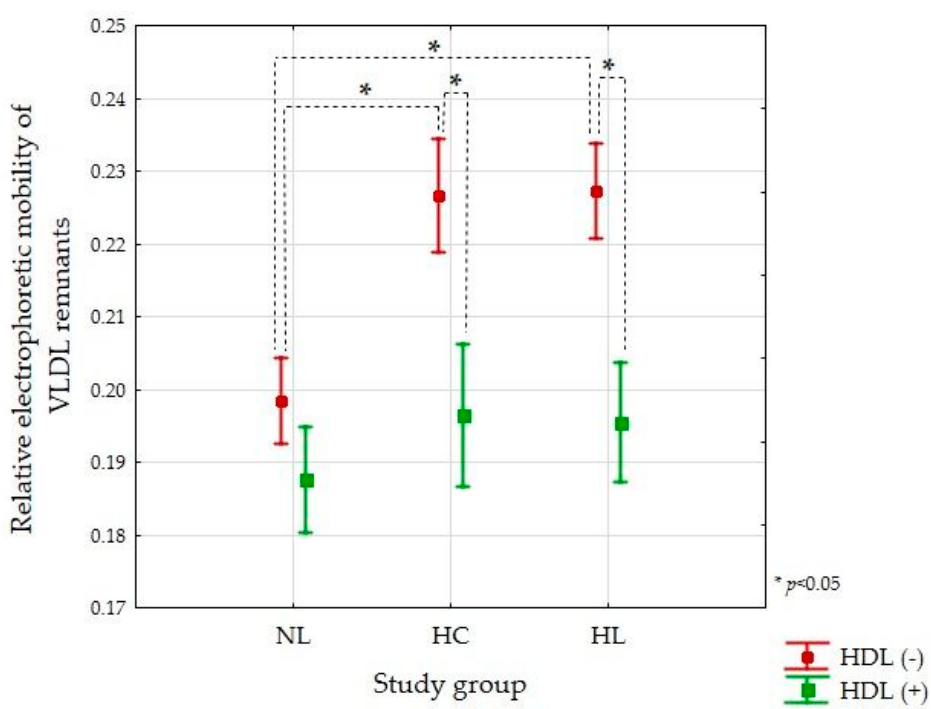
Figure 4. Relative electrophoretic mobility of VLDL remnants produced during LPL-mediated lipolysis in the absence and presence of HDL for the normolipidemic (NL, n = 9), hypercholesterolemic (HC, n = 6), and hyperlipidemic (HL, n = 7) groups. Data are presented as mean ± SE.